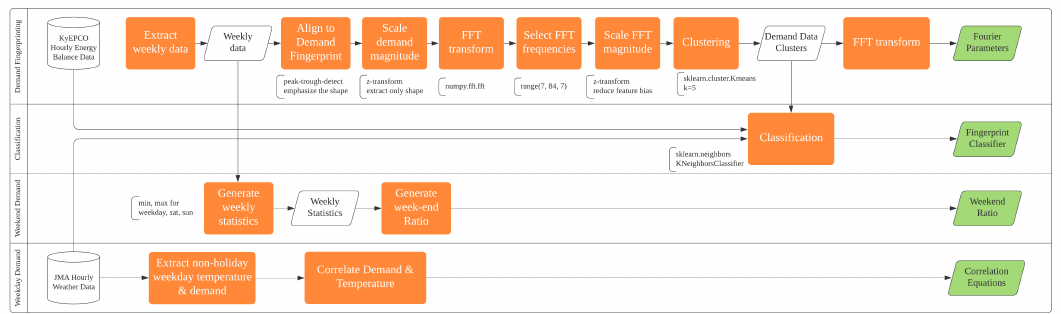
Figure 3. Generating the demand fingerprint based on the demand and temperature data.